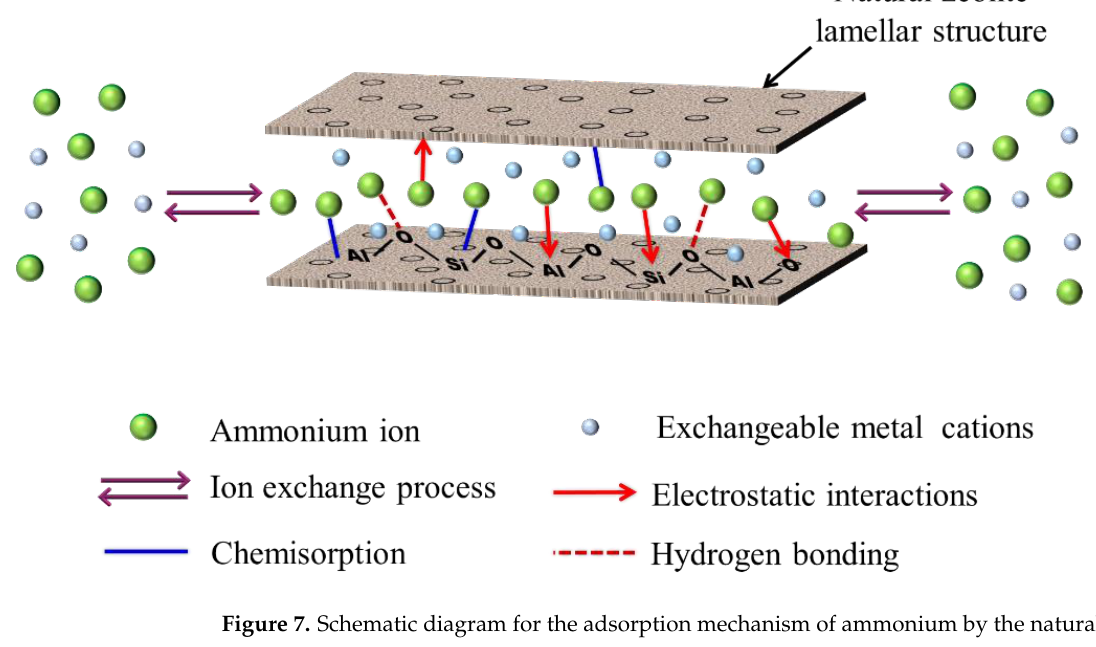
Figure 7. Schematic diagram for the adsorption mechanism of ammonium by the natural zeolite.